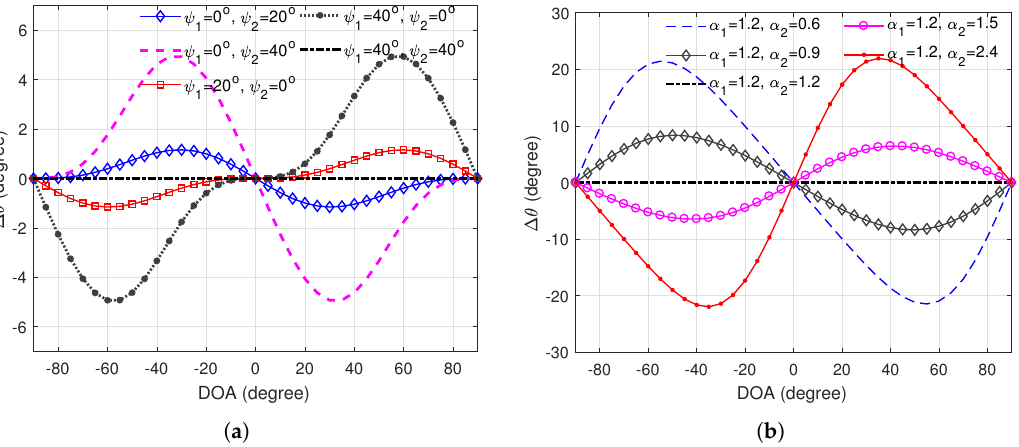
Figure 2. The direction of arrival (DOA) estimation error ( ∆ θ ) varying as a function of the DOA with: ( a ) different phase deviations but without amplitude deviation; ( b ) different amplitude deviations but without phase deviation. The positive DOA estimation error indicates that the estimated DOA is displaced clockwise from the actual DOA and vice